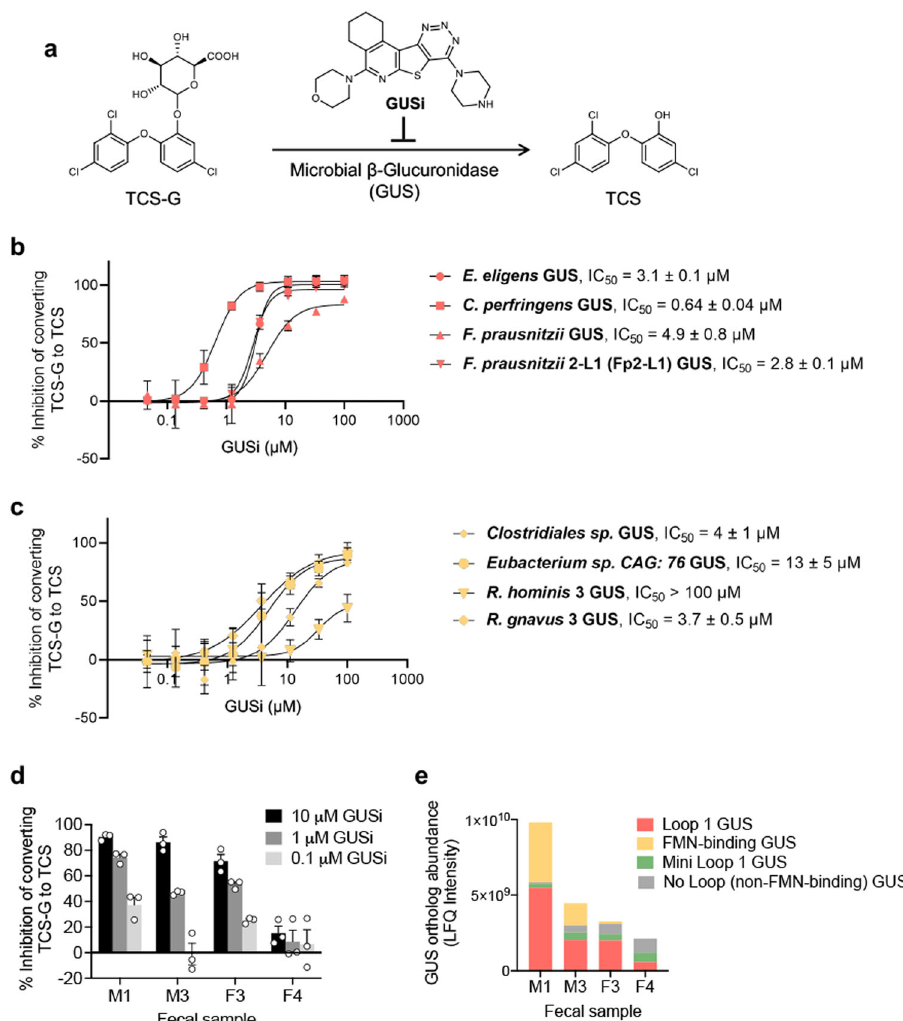
Fig. 4 GUSi inhibits the conversion of TCS-G to TCS by gut microbial GUS enzymes. a The effect of GUS inhibitor (GUSi; UNC10201652), on the conversion of TCS-G to TCS by gut microbial GUS enzymes. b GUSi inhibited the conversion of TCS-G to TCS catalyzed by puri fi ed Loop 1 GUS enzymes in vitro. c GUSi inhibited the conversion of TCS-G to TCS catalyzed by puri fi ed FMN-binding GUS enzymes in vitro. d GUSi inhibited the conversion of TCS- G to TCS catalyzed by enzymes extracted from human fecal samples ex vivo. e Abundance levels of GUS orthologs in human fecal samples as determined by activity-based probe-enabled proteomics. The data are mean ± SEM, n = 3 biological replicates. Source data are provided with this paper. TCS triclosan, TCS-G triclosan-glucuronide, GUS β -glucuronidase, GUSi β -glucuronidase